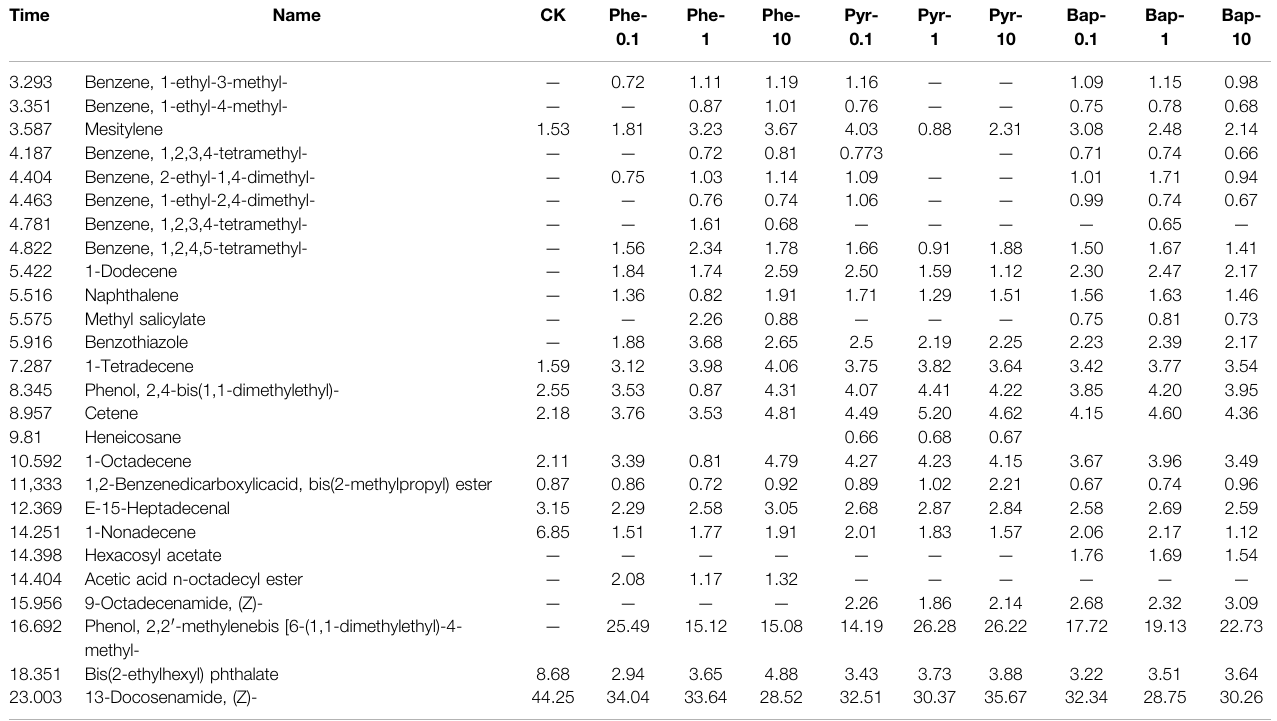
TABLE 3 | GC-MS measurement results of composition and relative content of root exudates after 45 days PAHs hydroponic stress. Time